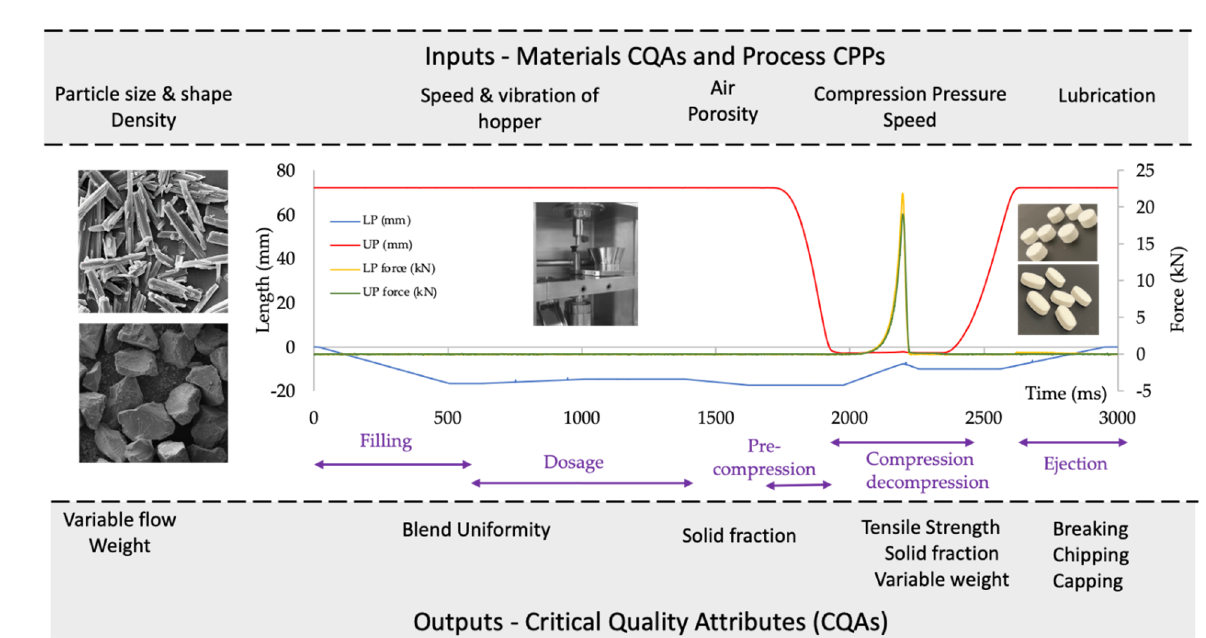
Figure 2. V-shaped profile (blue and red curves) indicating movements of the lower (LP) and upper punches (UP) over time and force (yellow and green curves) along in-process CQAs, material CQAs and CPPs per unit operation; pictures from left to right: SEM of crystalline ITZ (top) and milled ITZ-KOL-ASD (bottom), STYL’One nano round punch and hopper, and round and oblong tablets after compaction.